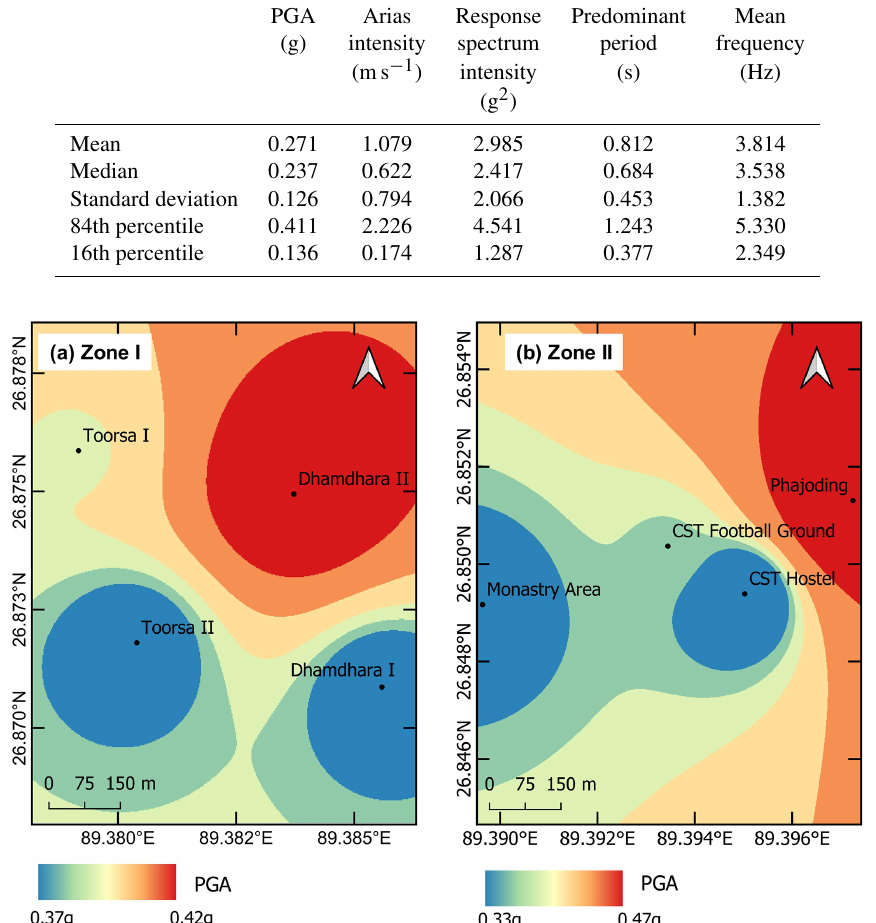
Figure 18. PGA distribution map of input motion M4 (Northridge) earthquake at (a) Toorsa and Dhamdhara in Zone I and (b) Rinchending in Zone